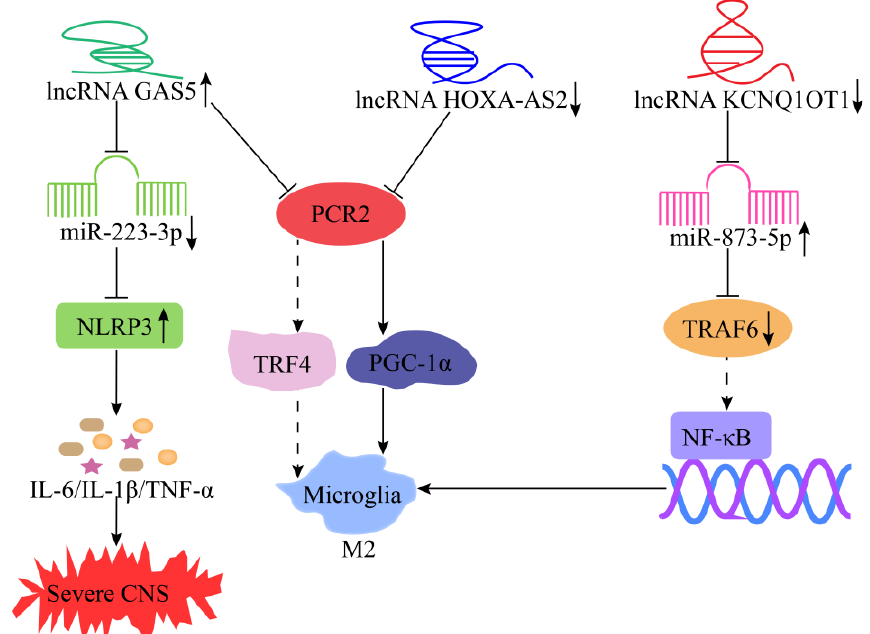
Figure 9. Mechanism of lncRNAs in the modulation of CNS inflammation. Knockdown of lncRNA KCNQ1OT1 promotes M2 polarization in microglia by targeting the miR-873-5p/TRAF6 axis. LncRNA GAS5 represses TRF4 transcription by binding to PCR2, thereby inhibiting microglia M2 polarization. Knockdown of lncRNA HOXA-AS2 increases PGC-1 α expression by binding to PCR2, which, consequently, promotes microglia M2 polarization. LncRNA GAS5 suppresses transcription of TRF4 by recruiting the PRC2, thus inhibiting M2 polarization. LncRNA GAS5 accelerates PD progression by targeting miR-223-3p/NLRP3 axis.